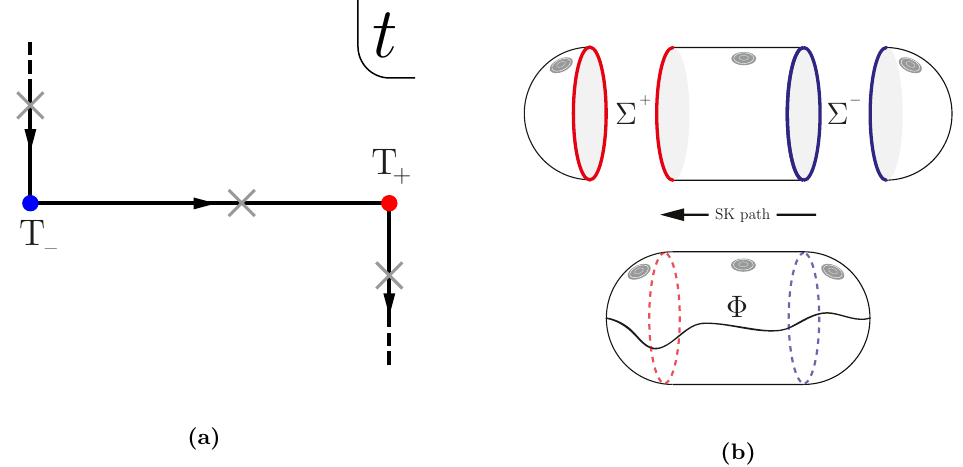
Figure 1. (a) In-Out SK-contour in the complex t -plane appropriate for describing a QFT tran- sition amplitude. The real-time evolution ∆ T = T is taken to infinity when computing + − T − scattering processes. Grey crosses represent operator insertions. (b) Bulk dual of the In-Out SK path depicted in (a). SvR dictionary associates either half Euclidean AdS spheres or Lorentzian AdS cylinders to each of the segments in (a). The pieces are C glued across Σ ± . The resulting 1 manifold provides the unique classical solution to the bulk fields eom’s with prescribed asymptotic boundary conditions represented by grey